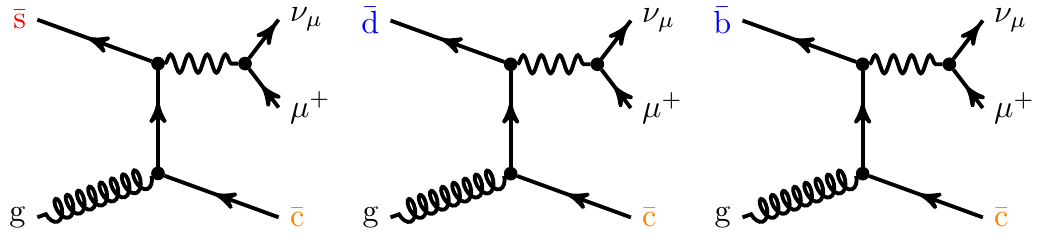
Figure 1 . Tree-level Feynman diagrams with diagonal CKM elements (left) and off-diagonal ele- ments (centre and right) for pp → µ + ν